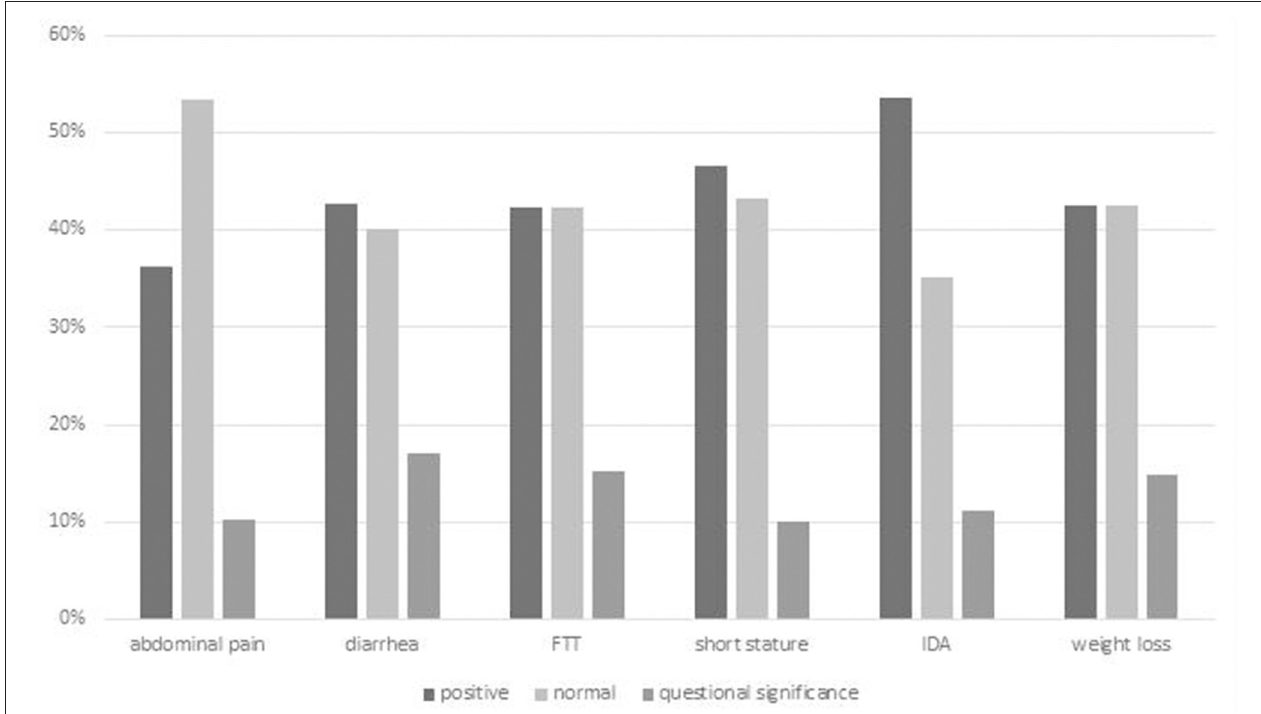
FIGURE 2 | Overall diagnostic yield of GIE by indication. Positive finding = definite diagnostic finding relating to indication; Questionable significance = finding of uncertain relationship to indication or minor finding of uncertain significance. FTT, failure to